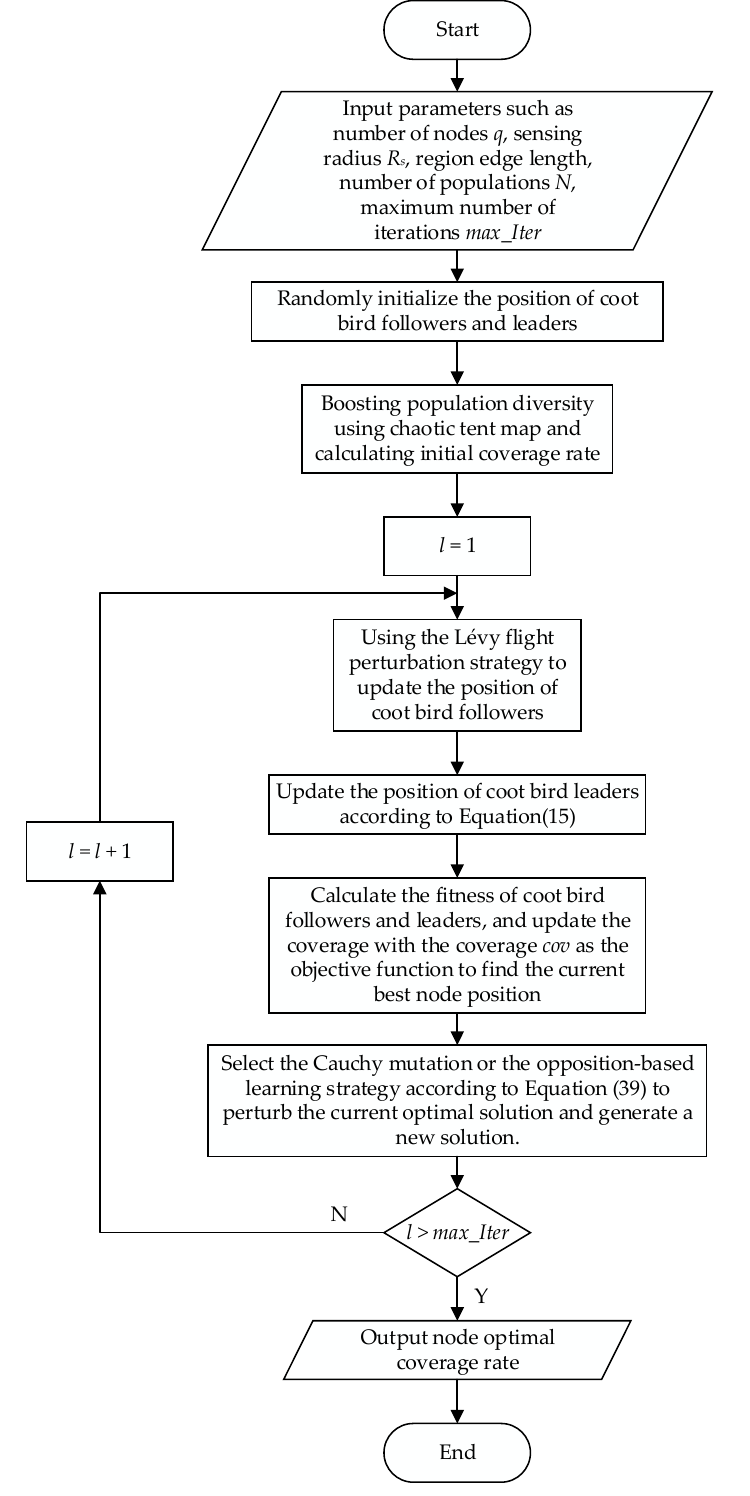
Figure 5. Flowchart of the COOTCLCO coverage optimization algorithm.